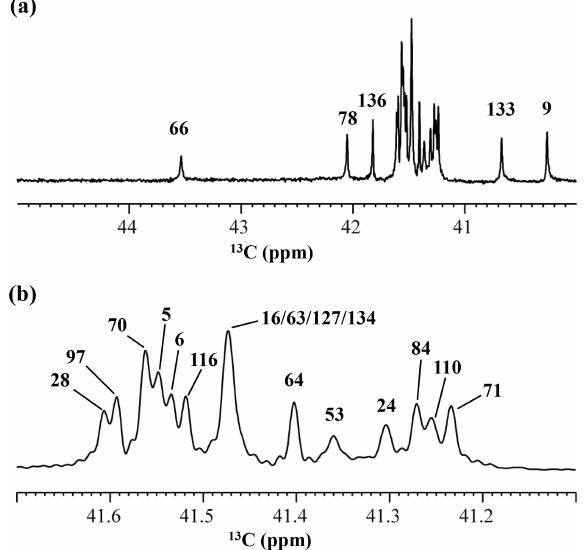
Figure 4. 125.7MHz { 1 H, 2 D}-decoupled 1D 13 C NMR spec- trum for the SNase variant selectively labeled with [ ε - 13 C; ε , ε -D 2 ]- Lys. The spectra were measured at 25 ◦ C, pH 8.0, in D 2 O solution on an Avance 500 spectrometer equipped with a DCH cryogenic probe. Although only a few discrete 13 C ε signals are apparent in panel (a) , the congested spectral region around 41–42ppm shows well-separated signals due to their narrow line widths of 1–2Hz (b) . All of the 1D NMR signals for 13 C ε were readily assigned using the chemical shift data, δ TSP ( 13 C) obtained from the 3D HCCH TOCSY experiment for the SNase variant selectively labeled with SAIL-Lys (see Sect. 3.1).